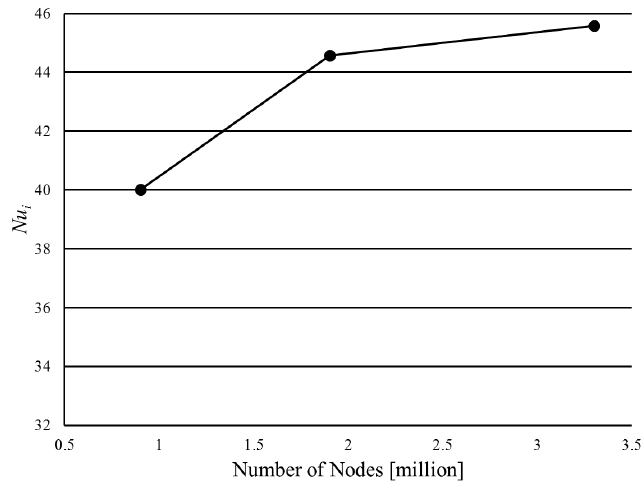
Figure 5. Grid dependency test.